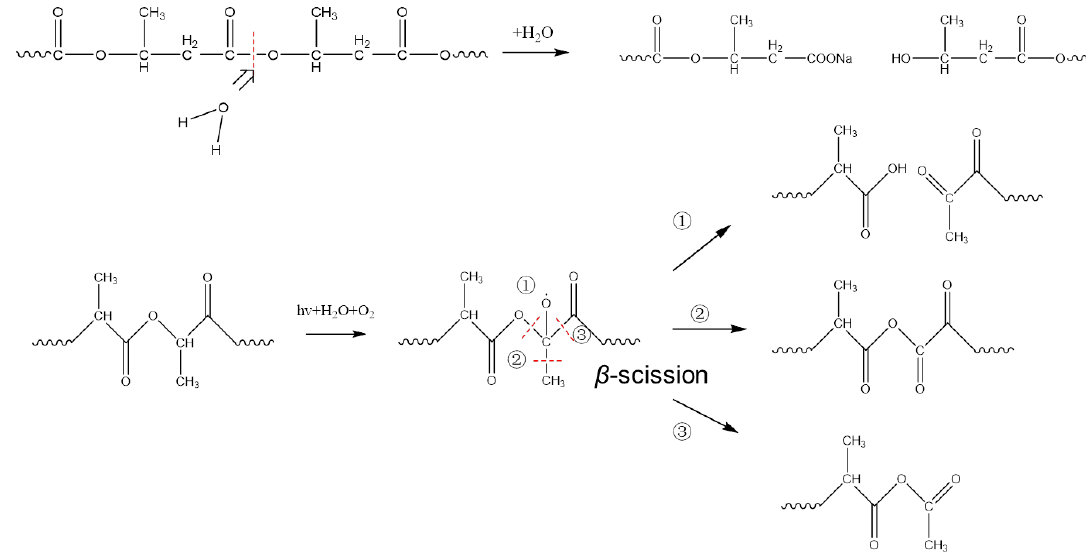
Figure 9. Degradation mechanism of PLA/PHB fabrics after immersion in natural seawater.